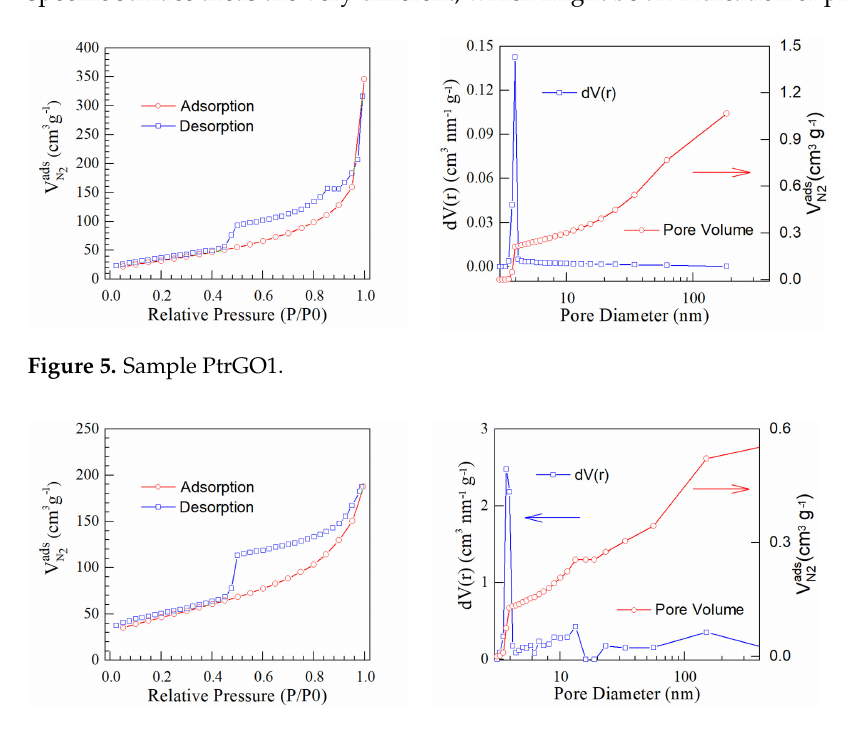
Figure 6. Sample PtrGO2.